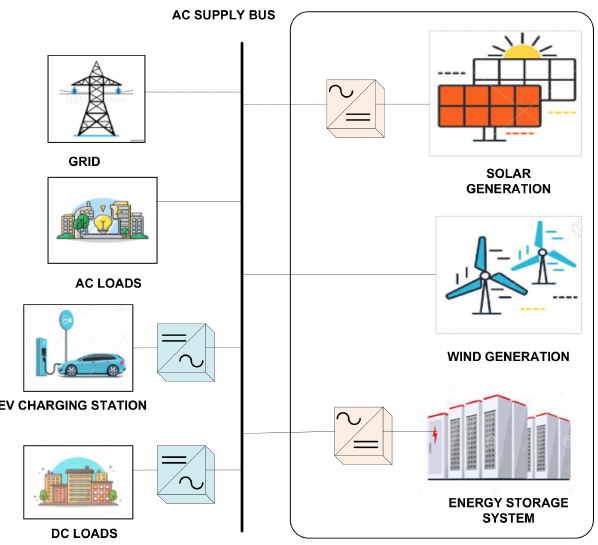
Figure 4. Structure of an AC